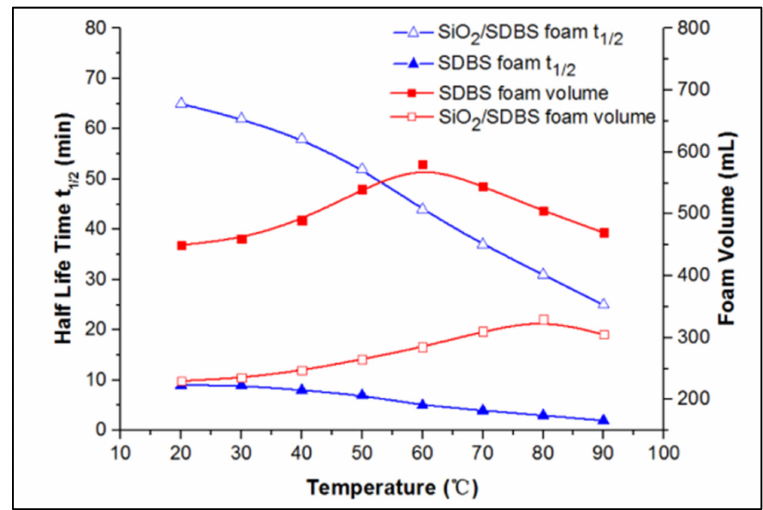
Figure 6. The decrement in the half-life of foam with increasing temperature (Reprinted with permission from Lv et al. [47]). Copyright 2015, American Chemical